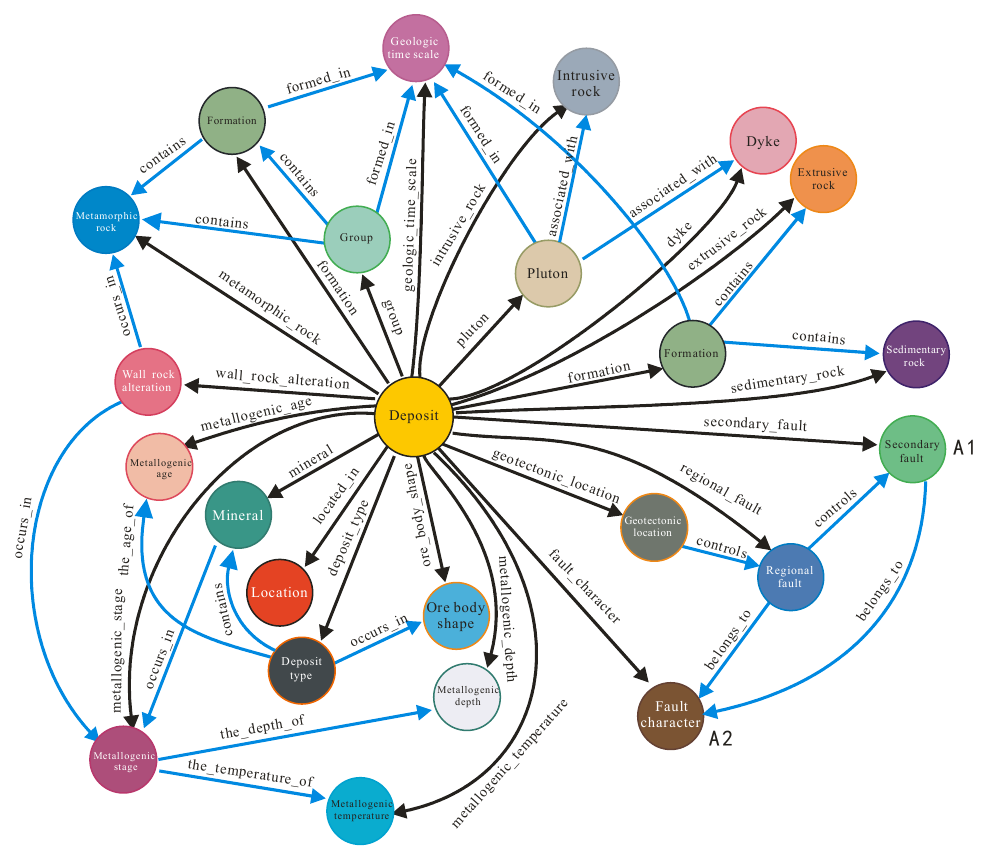
Figure 5. The construction structure of the KG for gold deposits. A1 is the node representing the secondary fault. A2 is the node representing the fault character.